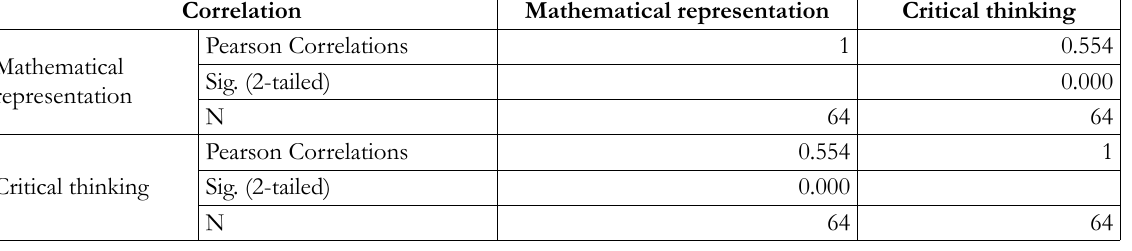
Table 9. Result of correlation test